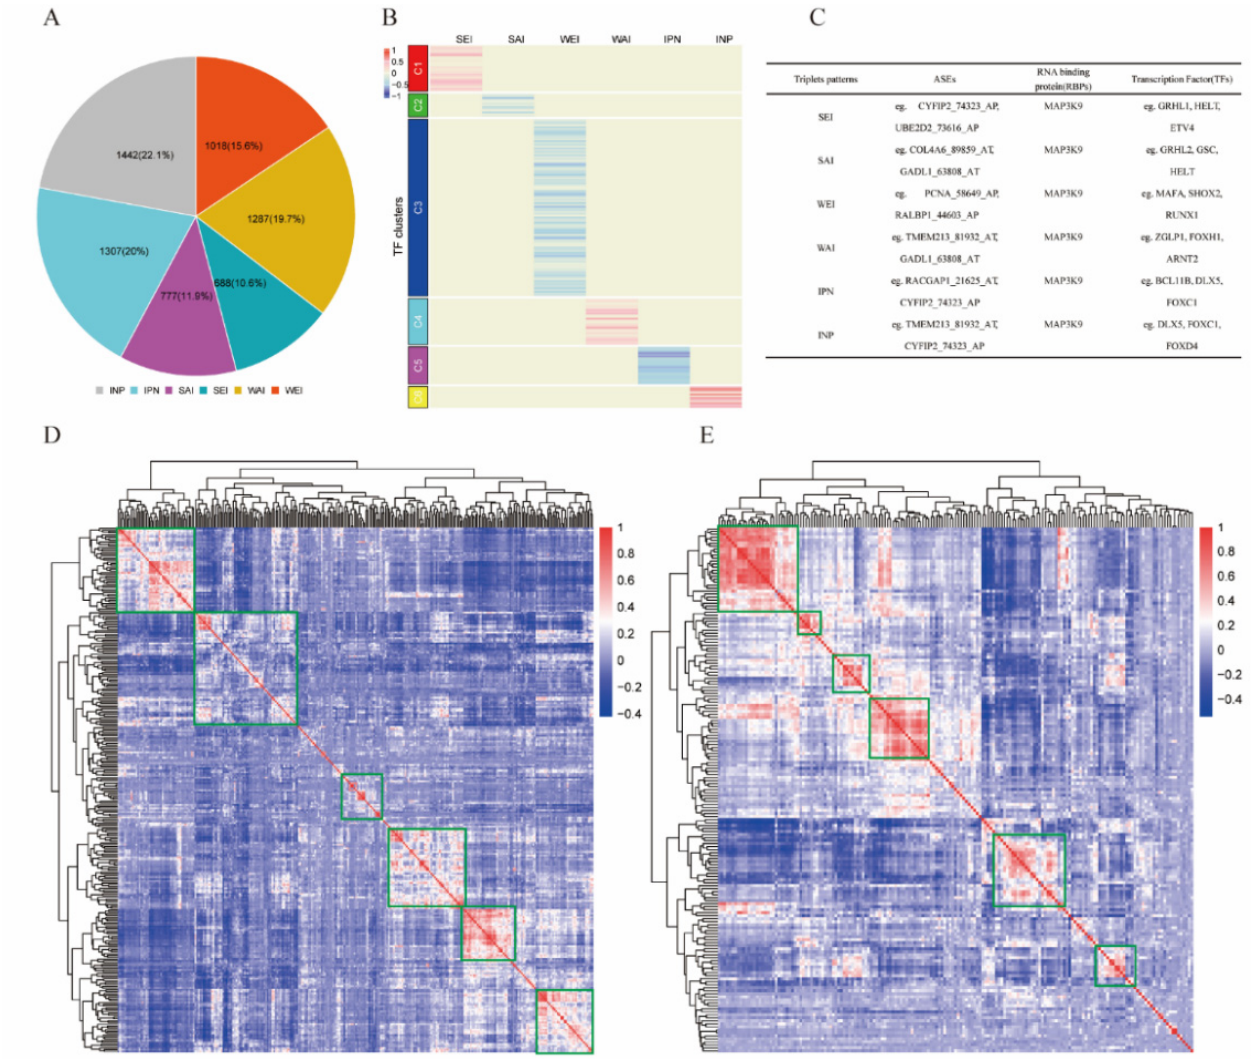
Figure 2. Identified triplets in KIRC. ( A ) Six mode subcategories of TFs according to correlation between expression of RBP and PSI value of ASE. Number in the pie chart means the percentage of each subcategory. ( B ) Clusters by the regulation patterns of TFs that are involved in the triplets containing the RBP MAP3K9. Six clusters were grouped according to TF subcategories. ( C ) Information of some representative triplets involved MAP3K9. ( D ) Correlation heat map of TFs involved in 6519 triplets. ( E ) Correlation heat map of RBPs involved in 6519 triplets.